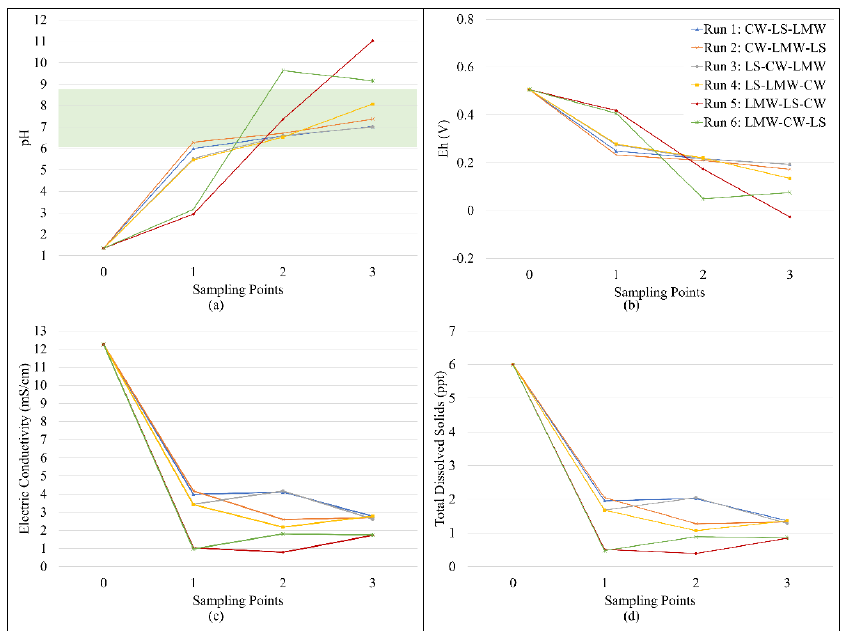
Figure 4. Change in ( a ) pH with Type C effluent standard highlighted in green [44,45], ( b ) Eh, ( c ) EC, and ( d ) TDS after each treatment media.